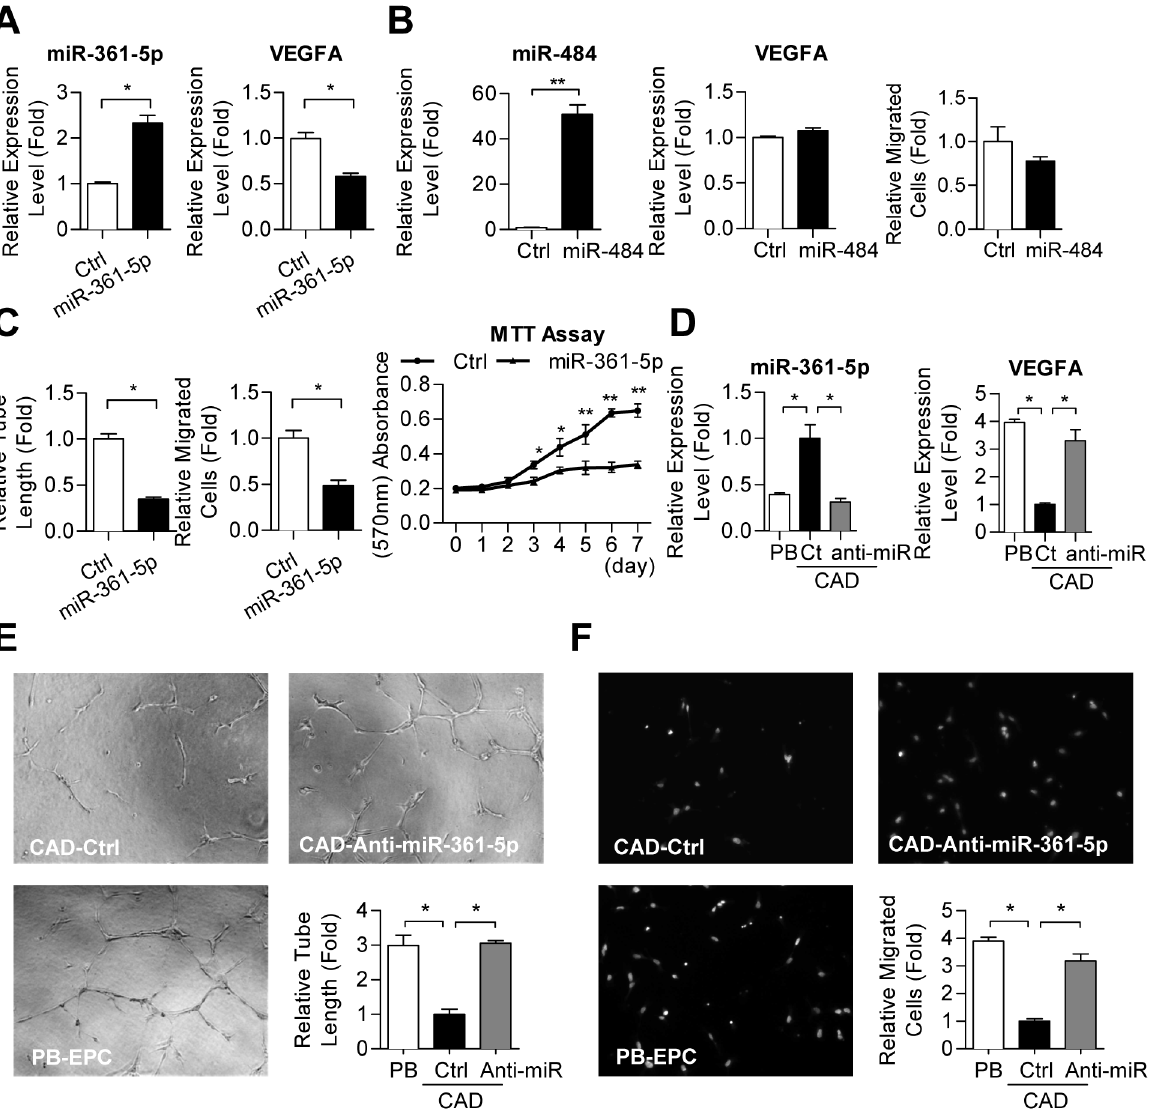
Figure 3. Suppression levels of miR-361-5p, not miR-484, restored VEGF expression and EPC functions. ( A ) Overexpression of miR-361- 5p in PB-EPCs down-regulated VEGF levels. *: p , 0.05, by Student’s T test. ( B ) Overexpression of miR-484 in PB-EPCs neither down-regulated VEGF levels ( middle panel ) nor inhibited cell motility ( right panel ). **: p , 0.01 by Student’s T test. ( C ) miR-361-5p transfectants showed reduced microtubule formation (left), cellular migration ( middle ), and cell proliferation ( right ) abilities. Representative pictures are shown in Suppl. Fig. 1 online. *: p , 0.05, **: p , 0.01 by Student’s T test. ( D–F ) Restoring miR-361-5p level in CAD-EPCs repairs EPC functions. ( D ): RT-qPCR shows that miR-361-5p oligonucleotide antagomir transfection represses CAD-EPC miR-361-5p to a level similar to that in normal PB-EPC controls. EPC vasculogenesis ( E )